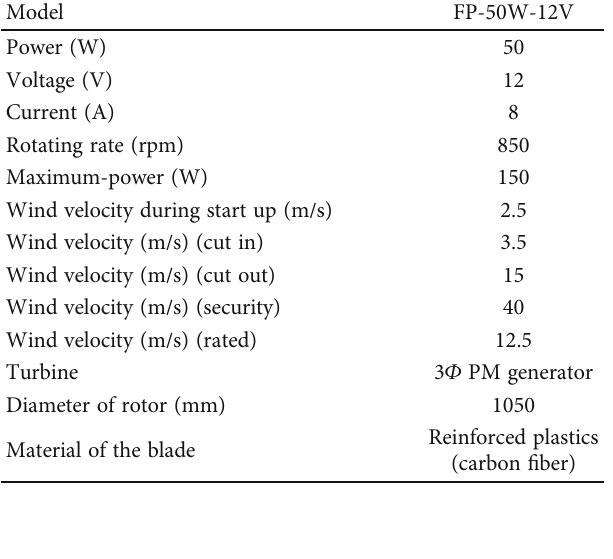
Table 2: Technical parameters of wind turbine [31].